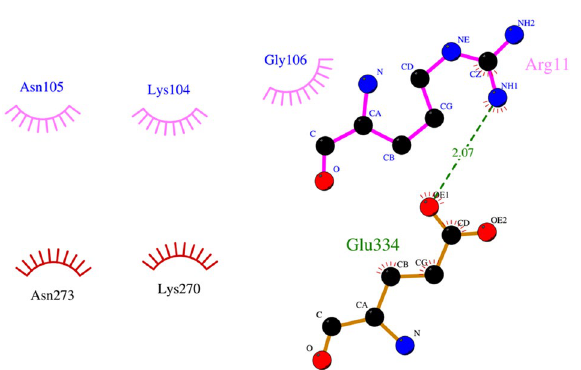
Figure 7. Molecular interactions between CHIKV E2 and PLA CB . 2D diagram of the interactions of the envelope glycoprotein E2 protein with PLA2 CB . The hydrogen bonds (green dashes) are shown between PLA2 CB (purple lines) and E1 glycoprotein (orange lines). Hydrophobic interactions are also shown between PLA2 CB (purple bows) and E1 glycoprotein (red bows). All images were generated using GraphPad Prism 8 and GIMP 2.10.20 (www. gimp.